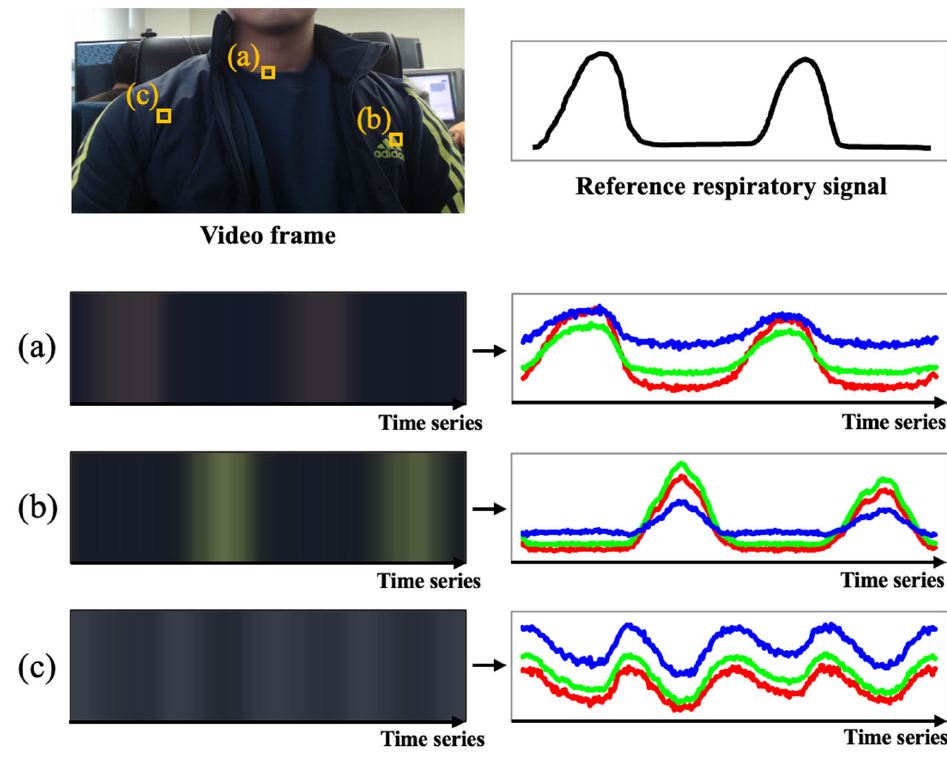
Figure 2. Examples of various pixel value changes that can occur as a result of the same breathing movement: ( a ) changes in pixel value that are similar to a reference breathing signal, ( b ) changes in pixel value that are opposite to the reference breathing signal, and ( c ) pixel value if the changes in the reference respiratory signal are not similar.